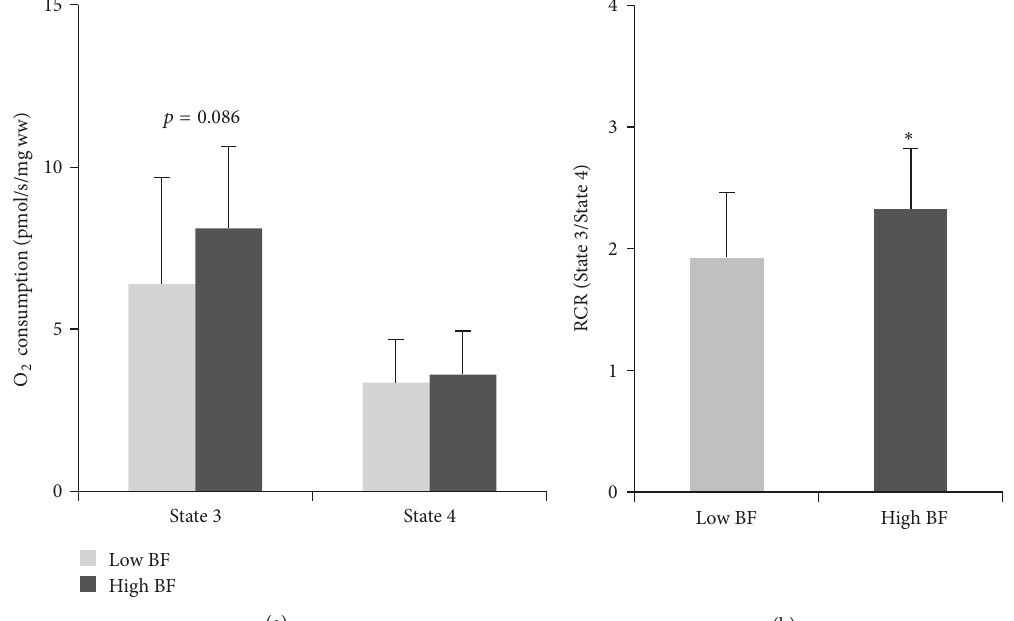
Figure 3: There were no differences in State 3 or State 4 between women with high body fat (BF) and women with low BF (a). RCR was significantly higher in women with high BF ( 𝑝 = 0.024 ) (b). ∗ 𝑝 < 0.05